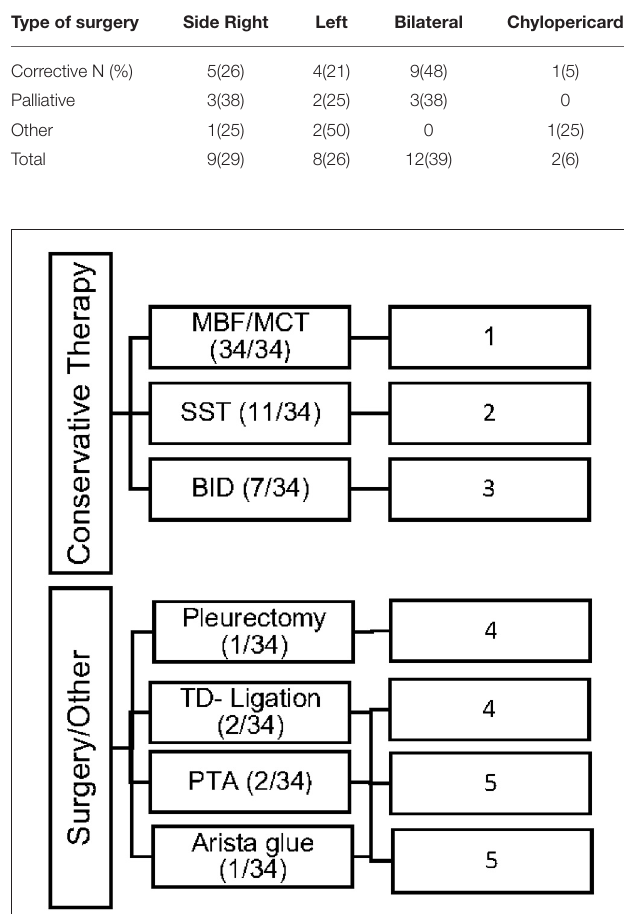
FIGURE 1 | Overview of the frequency of therapeutic interventions divided into 5 categories of therapy (Type 1–5).